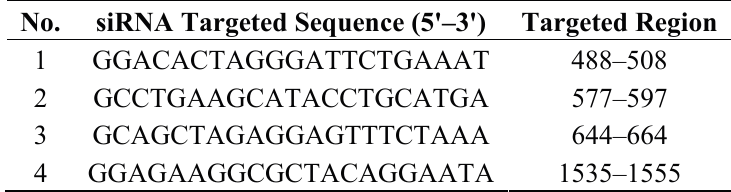
Table 1. Specific siRNA targeted region for mouse Clu